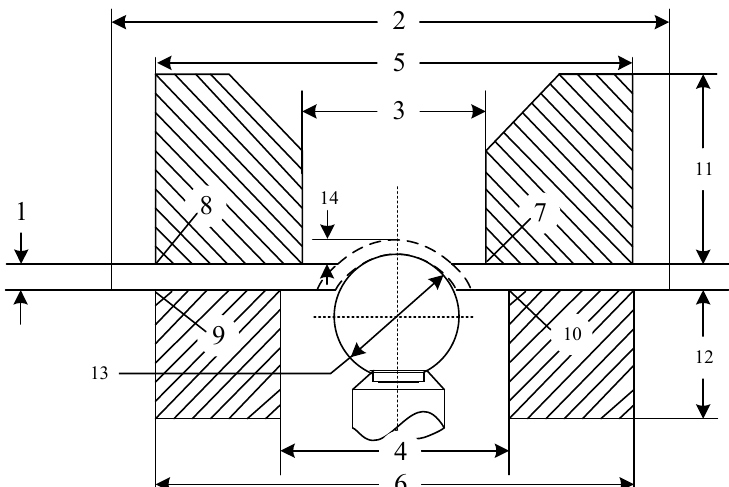
Figure 8. Hemispherical part drawing model (mm): 1. Sheet thickness, 2. Sheet diameter, 3. Die diameter, 4. Blank holder diameter, 5. Die outer diameter, 6. Outer diameter of the blank holder, 7. Profile radius of the Die, 8. Outer profile radius of the die, 9. Outer profile radius of the blank holder, 10. Profile radius of the blank holder, 11. Die thickness, 12. Blank holder thickness, 13. Punch diameter, 14. Drawing depth.